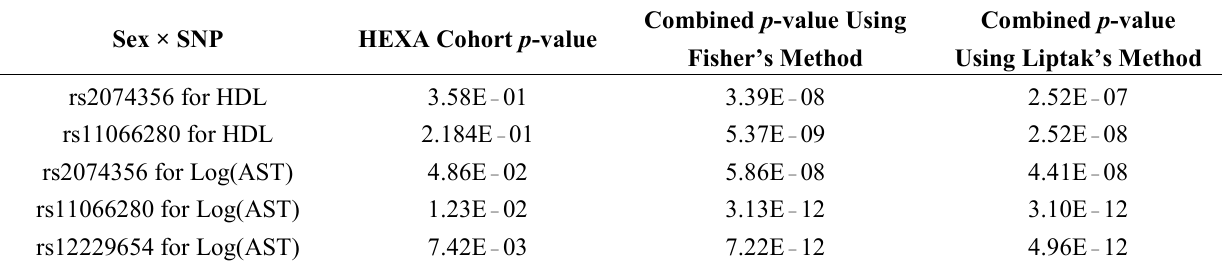
Table 9. Combined p -values for gene × environment interaction. For replication, interactions of sex with SNPs were tested in the HEXA cohort and a combined p -value was calculated using both Fisher’s and Liptak’s methods. Combined p -value Using Combined p -value Sex × SNP HEXA Cohort p -value Fisher’s Method Using Liptak’s Method rs2074356 for HDL 3.58E − 01 3.39E − 08 2.52E − 07 rs11066280 for HDL 2.184E −